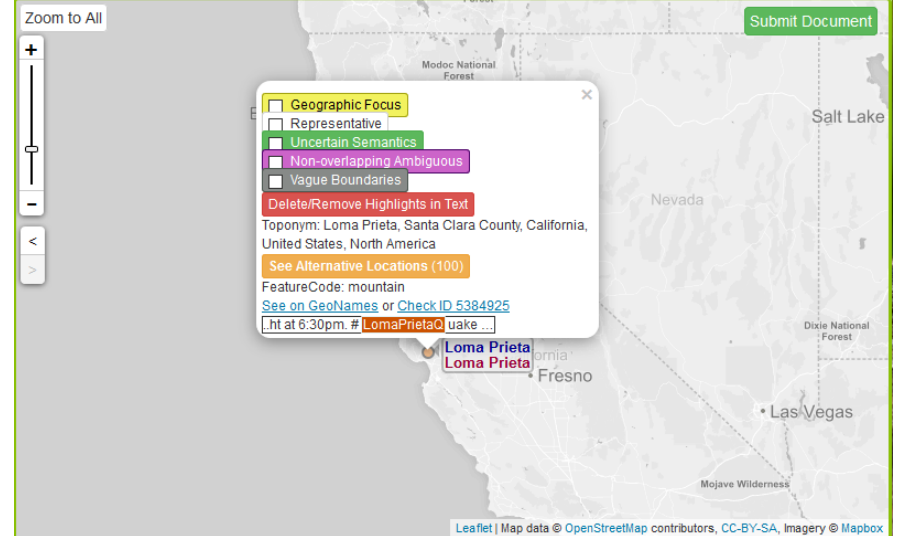
Figure 4. Adding special tags to a toponym by invoking the toponym popup.